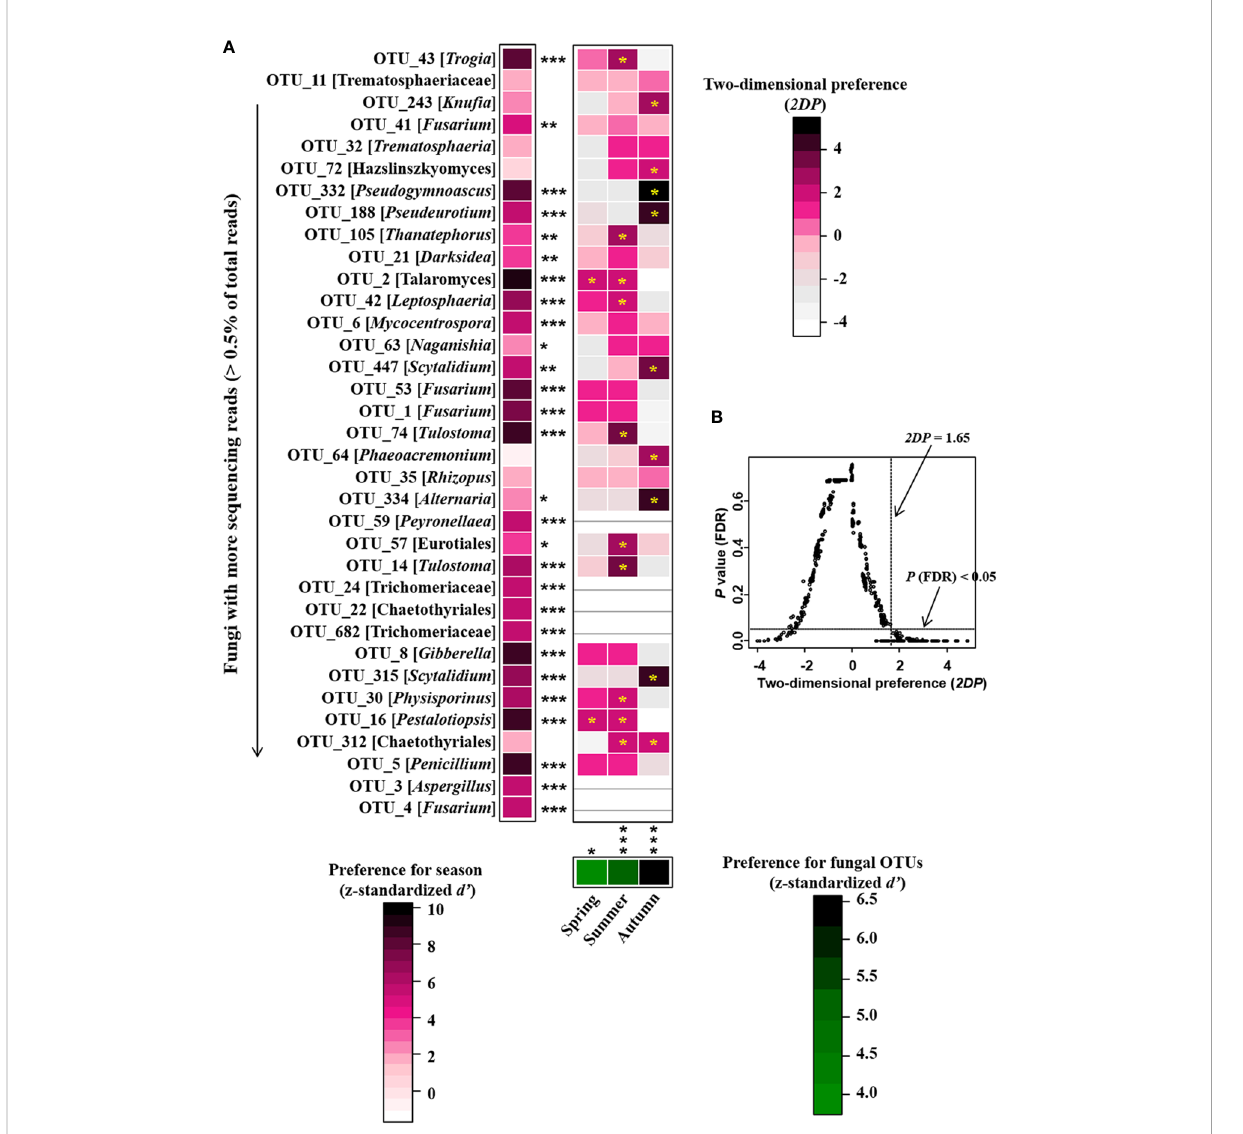
FIGURE 6 Preferences observed in season-fungus associations on roots of P. mongolica . (A) standardized d ’ estimates of preferences for fungal operational taxonomic units (OTUs) for indicated season (columns). Likewise, the standardized d ’ estimate of preferences for season is indicated for each of the observed fungal OTUs (row). A cell in the matrix indicates a two-dimensional preference ( 2DP ) estimate, indicating the extent an association of a focal season-fungus pair was observed more/less frequently than expected by chance. The cell with asterisk inside represents signi fi cant preferences in season-fungus pair. Because multiple species/OTUs were tested, the P values are shown as false discovery rates (FDRs) in the season-fungus preference analysis. (B) relationship between 2DP and FDR-adjusted P values, 2DP values larger than 1.65 represented strong preferences. Signi fi cance: * P < 0.05, ** P < 0.01, *** P <